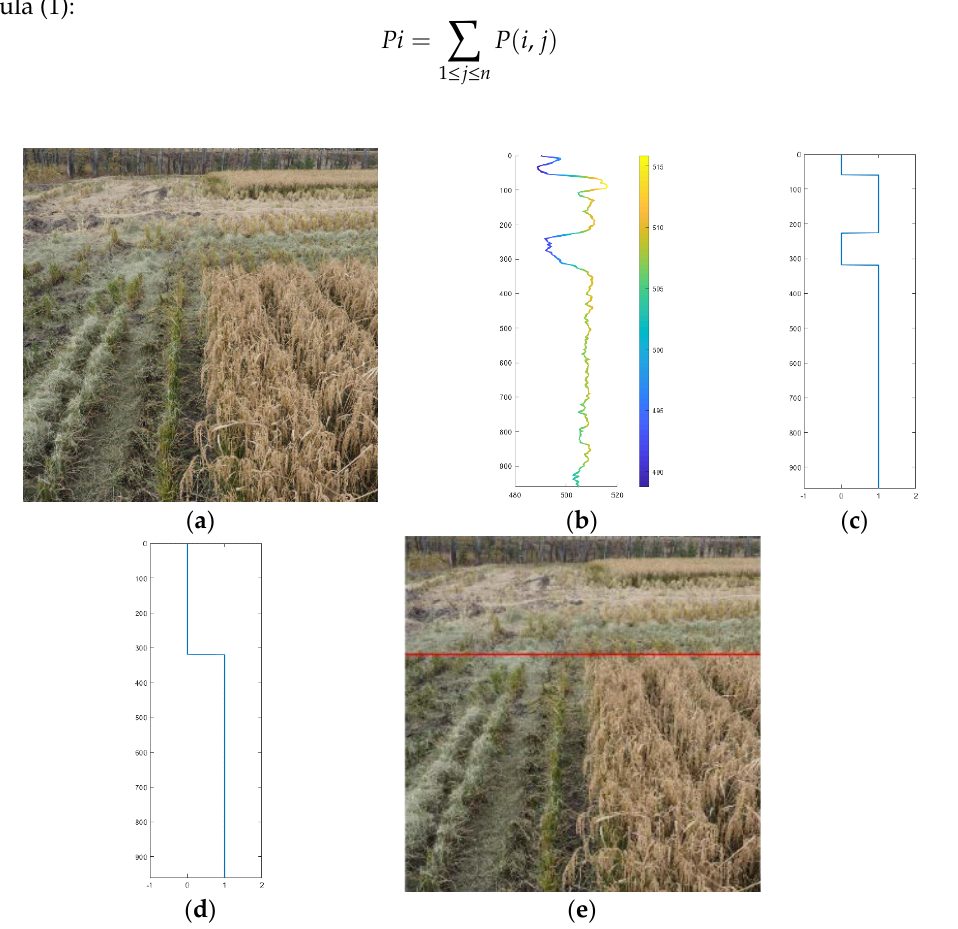
Figure 3. Horizontal projection results: ( a ) Image to be extracted; ( b ) Horizontal projection results; ( c ) Shaped results; ( d ) Preserved area of interest; ( e ) Extracted results.